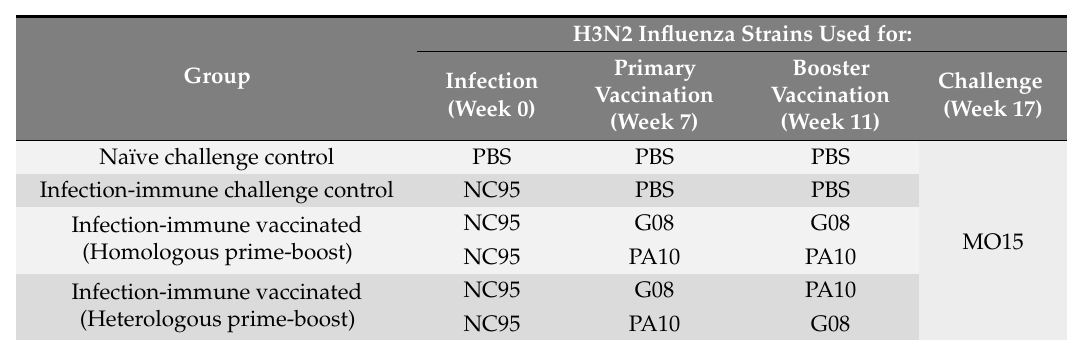
Table 2. Design of experiment